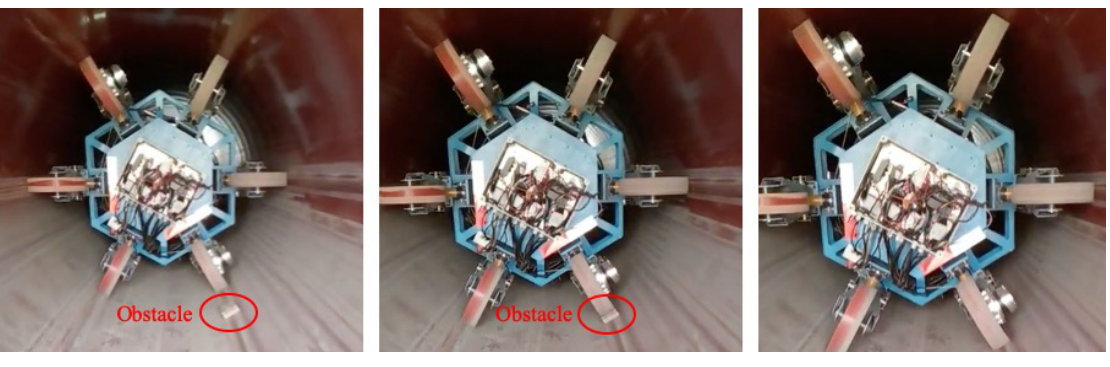
Figure 8. Inspection robot passes over an